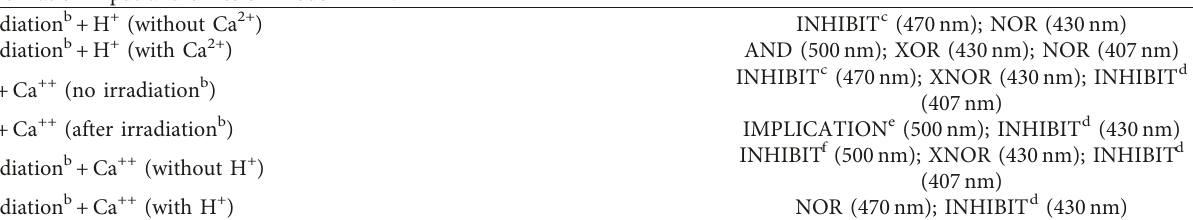
Table 3: Molecular logic operation for MLG1 starting from MLG1 enriched in the trans isomer using two ionic inputs and photo- isomerization input and emission mode in nm.